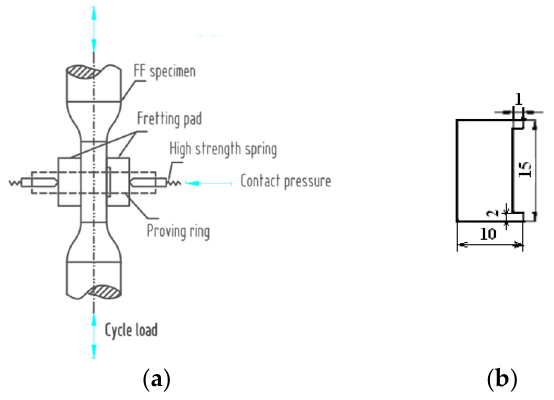
Figure 4. ( a ) Schematic diagram and ( b ) fretting contact pad of FF equipment (unit: mm).